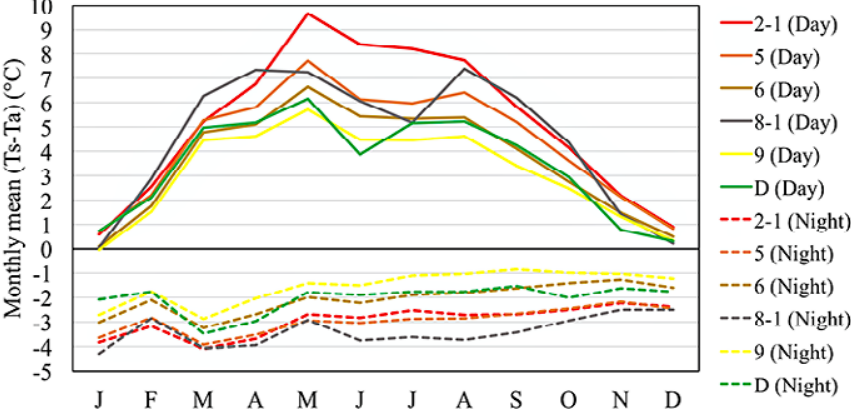
Figure 4. Annual variation of the diurnal and nocturnal T